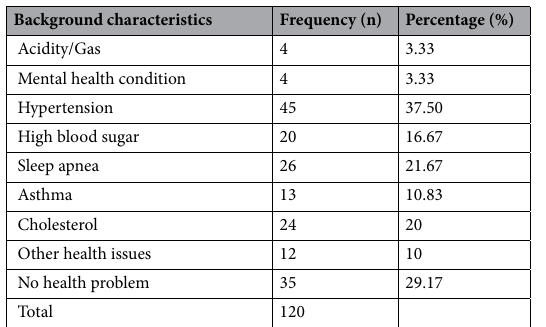
Table 1. Descriptive statistics of the survey participants, Kolkata, 2019–20. ^Had suffered or presently living with the specific health problems and/or under the medication. *Among 60 female participants. Source: Primary Survey.